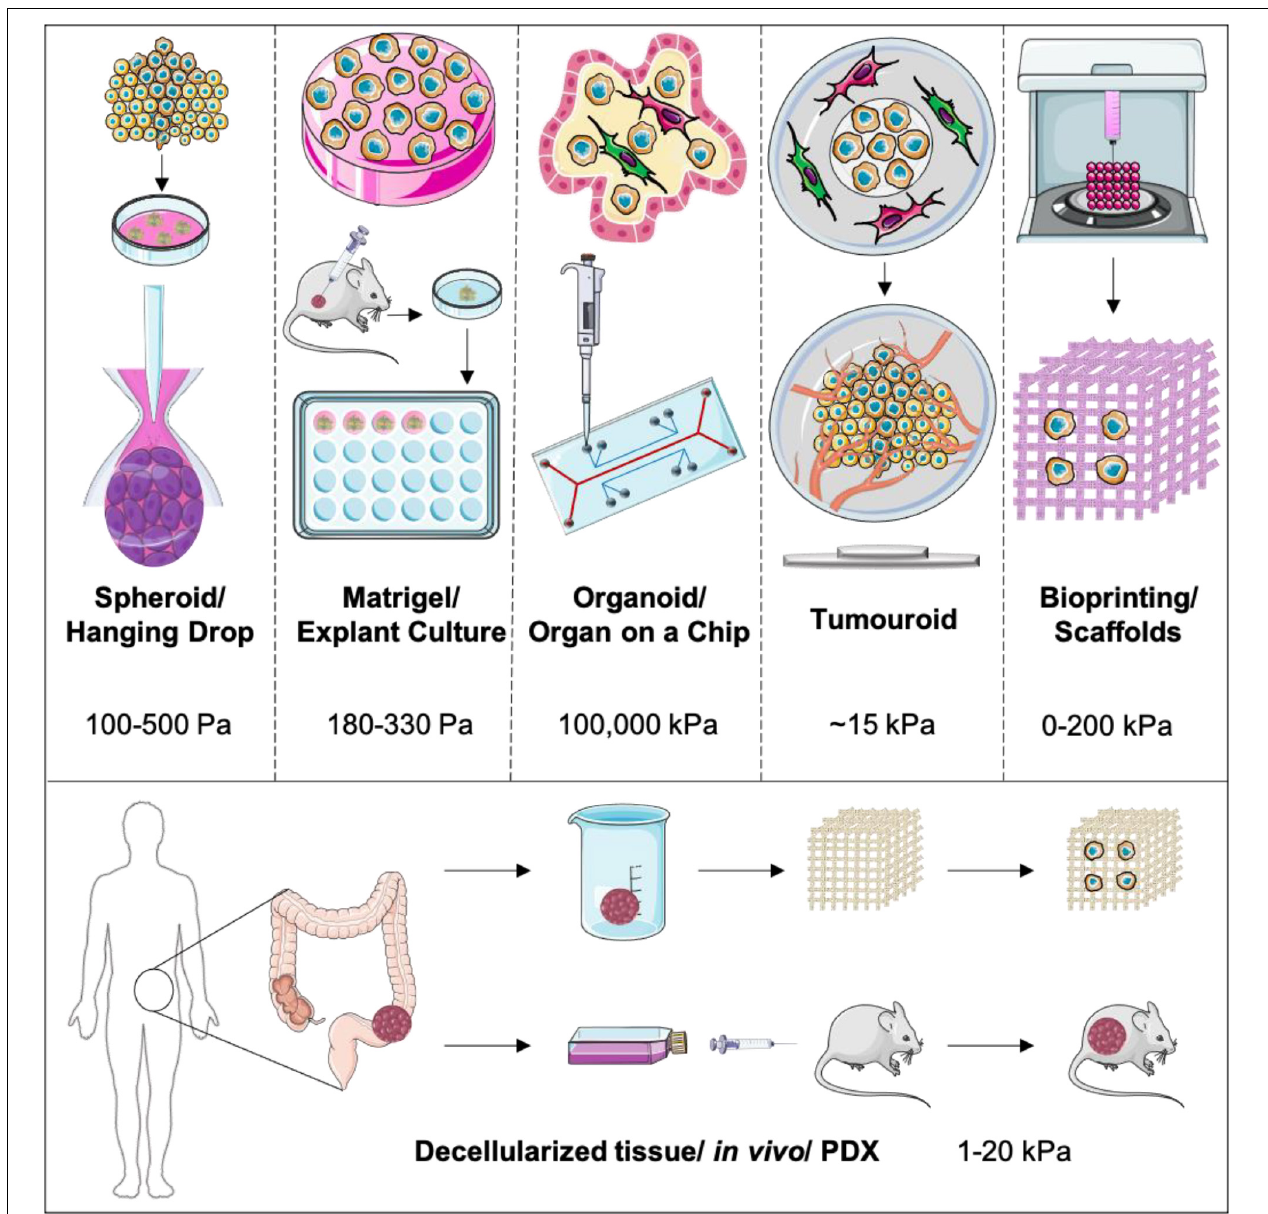
FIGURE 1 | Outlining the main 3D models used currently to model cancer and the cancer stroma. These are represented with increasing biomimicry and complexity placing PDX and in vivo models as the golden